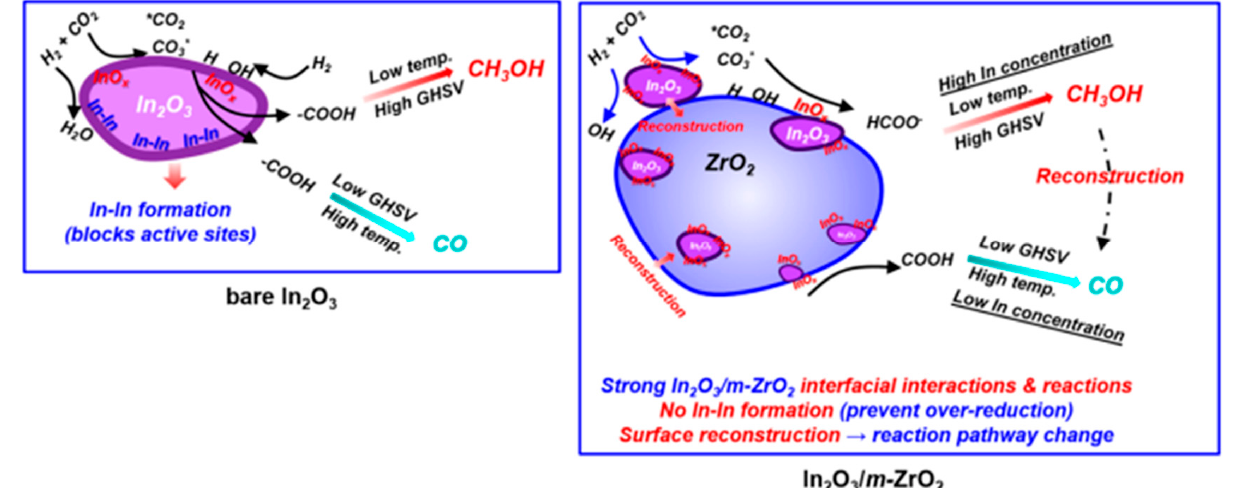
Figure 10. Reaction mechanism pathway on bare In 2 O 3 and di ff erent In 2 O 3 /m-ZrO 2 catalysts. Reproduced with permission from ref. [100]. Copyright 2022 American Chemical Society.